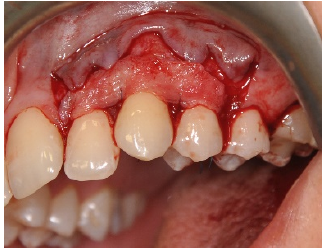
Figure 8. Placement and immobilization of CTG graft at the recipient site.